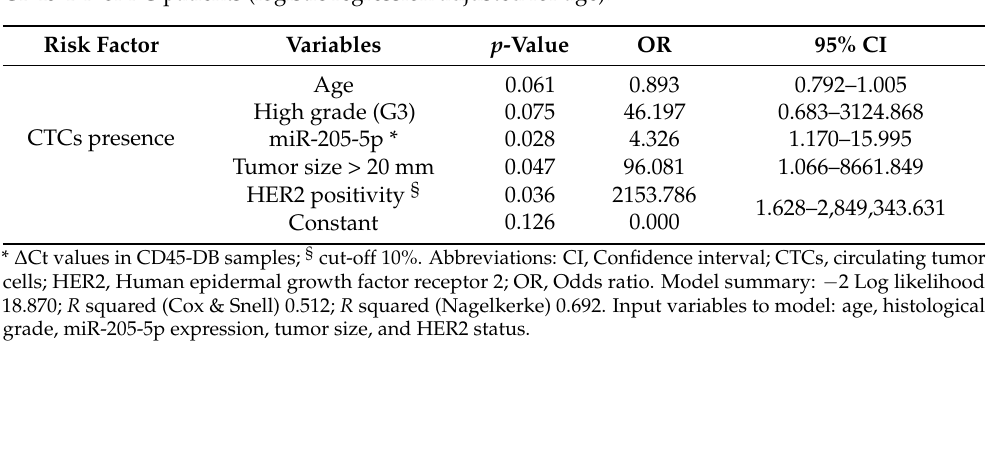
Table 4. Risk estimation of miR-205-5p expression and clinical status for the presence of CTC in CD45-DB of BC patients (logistic regression adjusted for